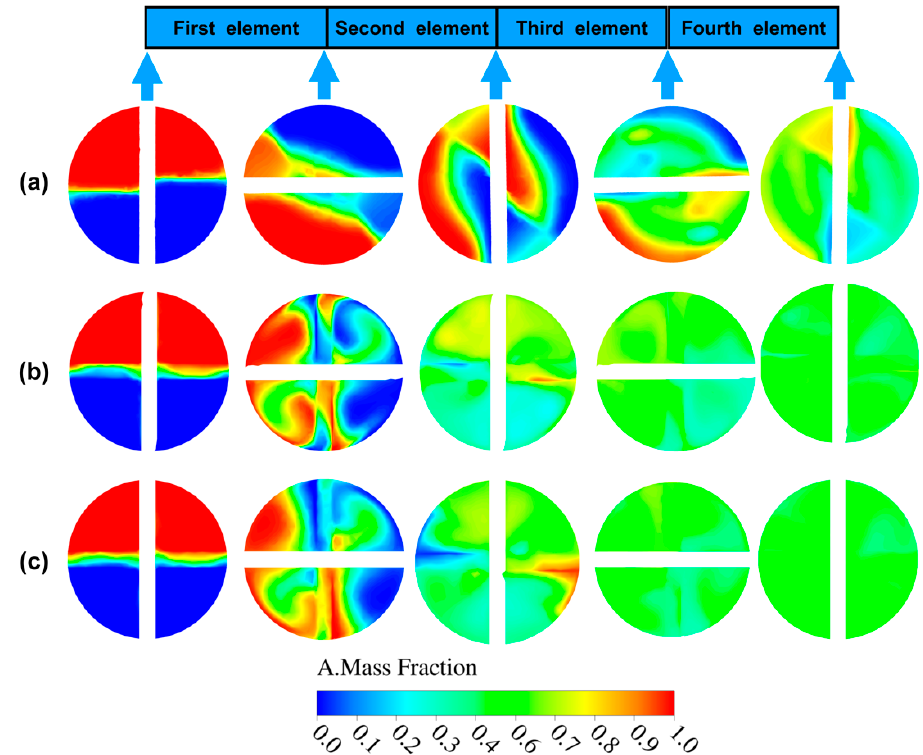
Figure 11. Effect of aspect ratio on cross sectional profiles of concentration at Re = 500: ( a ) AR = 0.4; ( b ) AR = 0.8; ( c ) AR = 1.5.